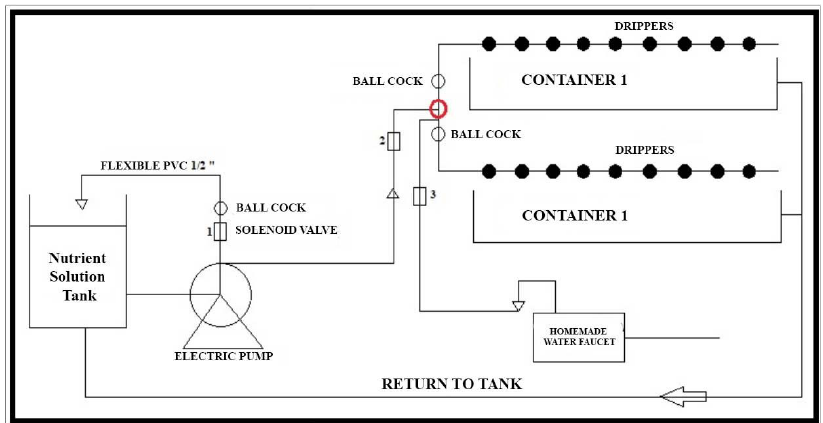
Figure 5. Implemented irrigation system scheme.